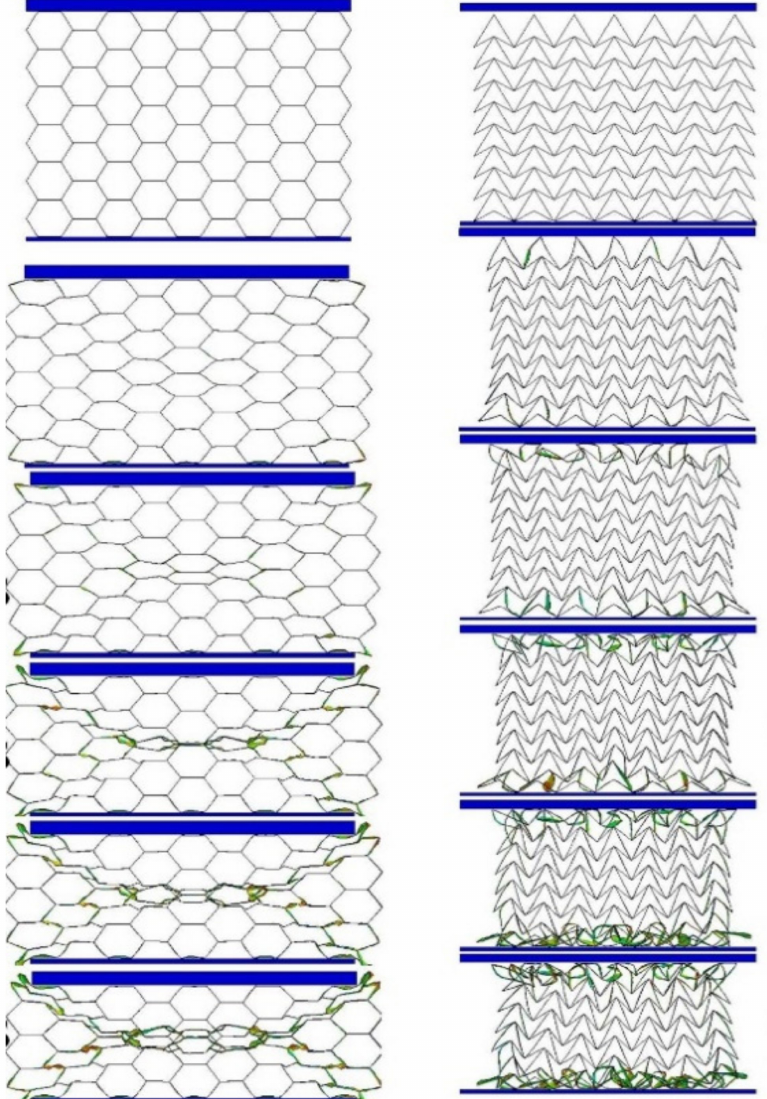
Figure 2. Deformations and the collapse modes of honeycomb structure in compression, hexagonal honeycomb ( left ); and arrow honeycomb ( right